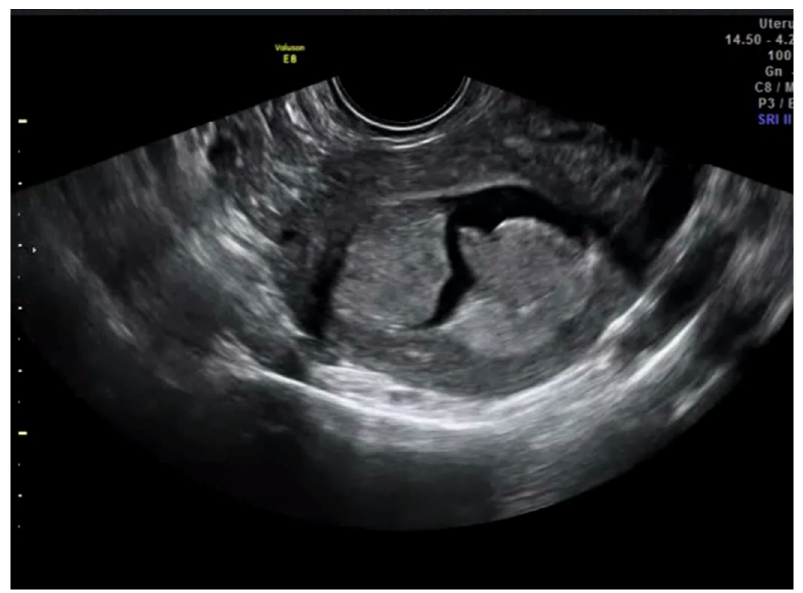
Figure 4. Transvaginal ultrasound showing a case of deep infiltration in endometrial cancer according to subjective impression.